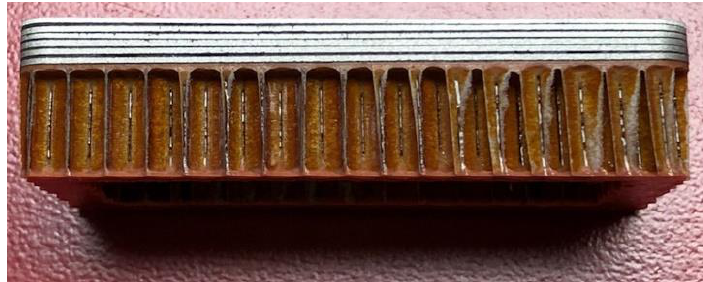
Figure 23. Typical optimum stack heights for two metals.